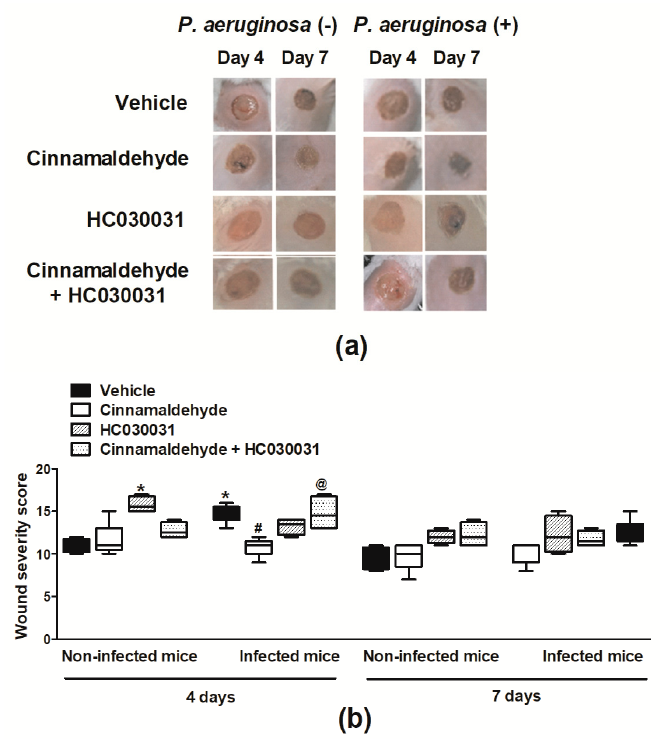
Figure 4. E ff ects of topical cinnamaldehyde or systemic TRPA1 antagonism on wound severity. Wound severity was macroscopically evaluated. Representative photographs ( a ) and severity scores ( b ) of the wounds on days 4 and 7 post ‐ skin excision. Animals received either sterile saline or P. aeruginosa ATCC 27853 following skin excision. Cinnamaldehyde (0.5 mg/mL; 30 μ L, n = 6) or 2% DMSO in sterile saline (30 μ L, n = 6) were topically applied once a day for over seven days. The TRPA1 antagonist HC ‐ 030031 (30 mg / kg, i.p., n = 6) or vehicle (8% DMSO in saline, i.p., n = 6) were administered to animals receiving cinnamaldehyde or not. * p < 0.05, di ff ers from vehicle-treated non-infected mice; # p < 0.05, di ff ers from vehicle-treated P. aeruginosa infected mice; @ p < 0.05, di ff ers from cinnamaldehyde-treated P. aeruginosa infected